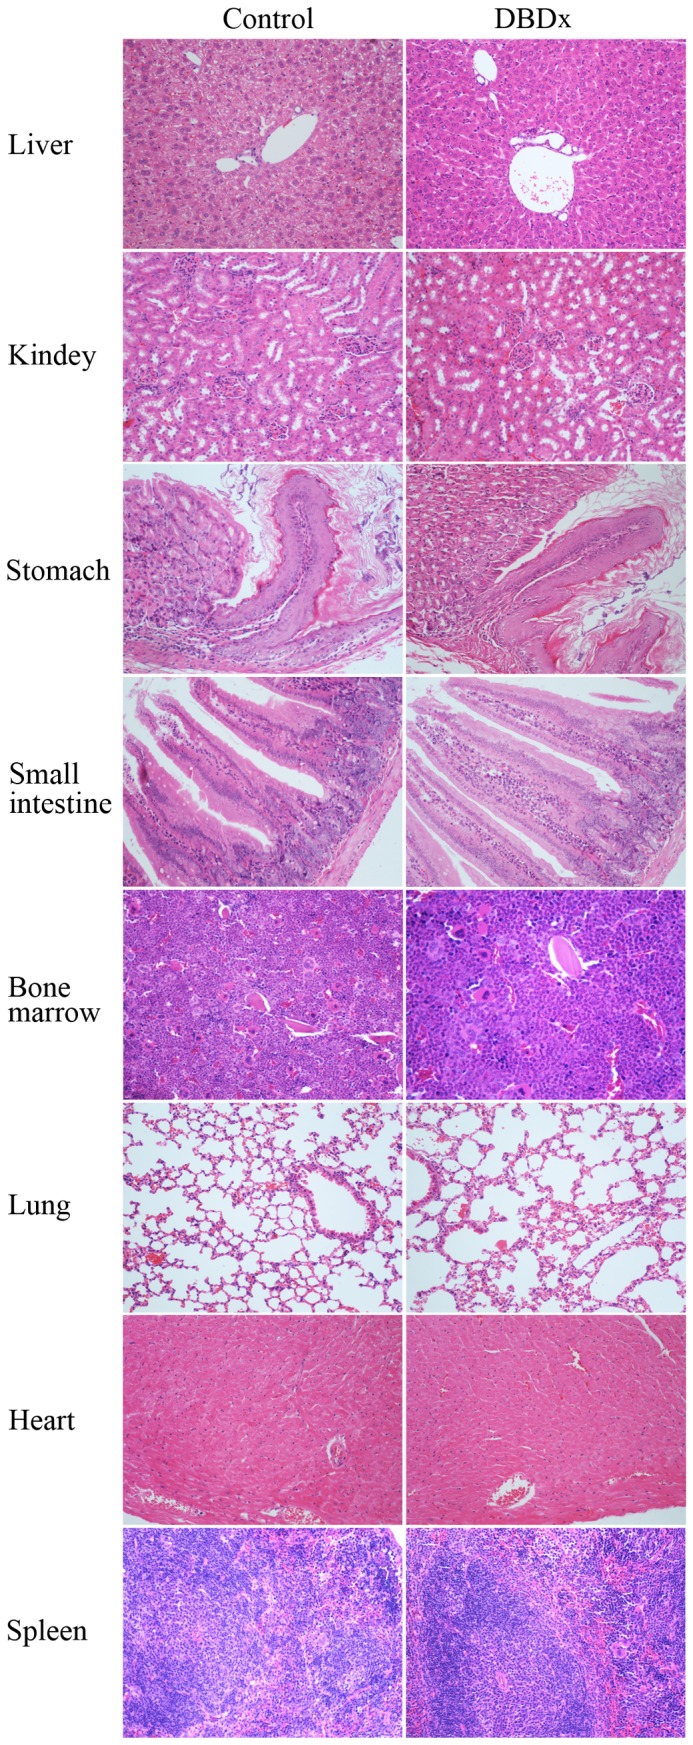
Toxicological studies in mice.Histopathological examination in HepG2 xenograft-bearing mice of the control group and the group treated with DBDx. No pathological changes were found in liver, kidney, stomach, intestine, bone marrow, lung, heart and spleen in DBDx-treated animals (H&E). (×200).